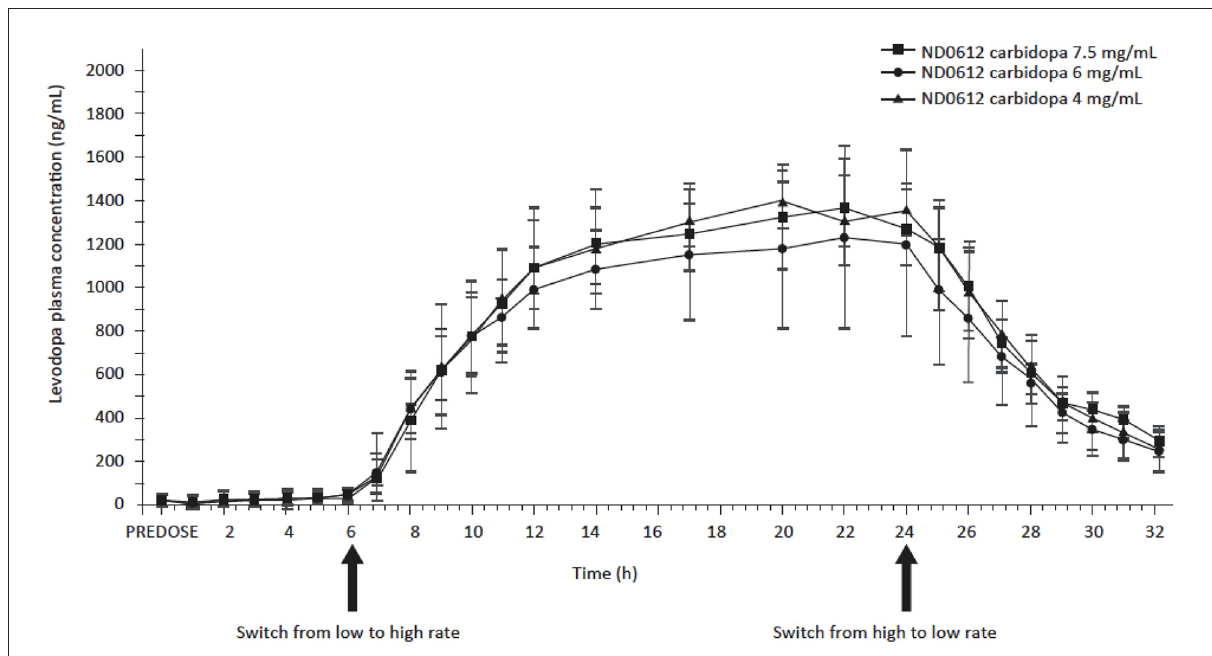
FIGURE5 Mean plasma levodopa concentrations following continuous SC administration of ND0612 (high dose) with varying carbidopa